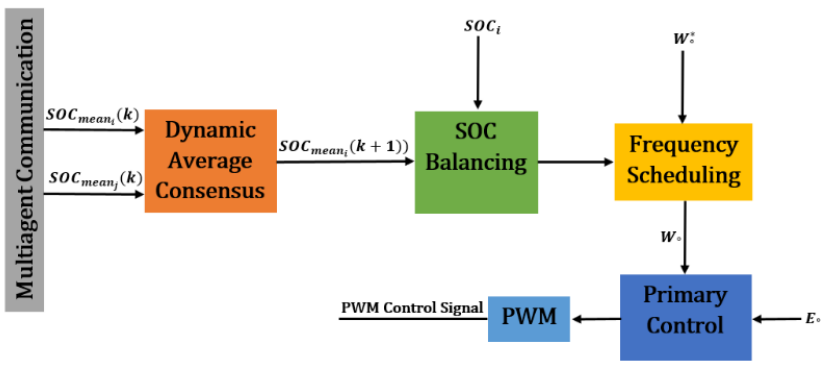
Figure 11. Secondary multiagent frequency scheduling of an independent storage agent, to balance SOC.